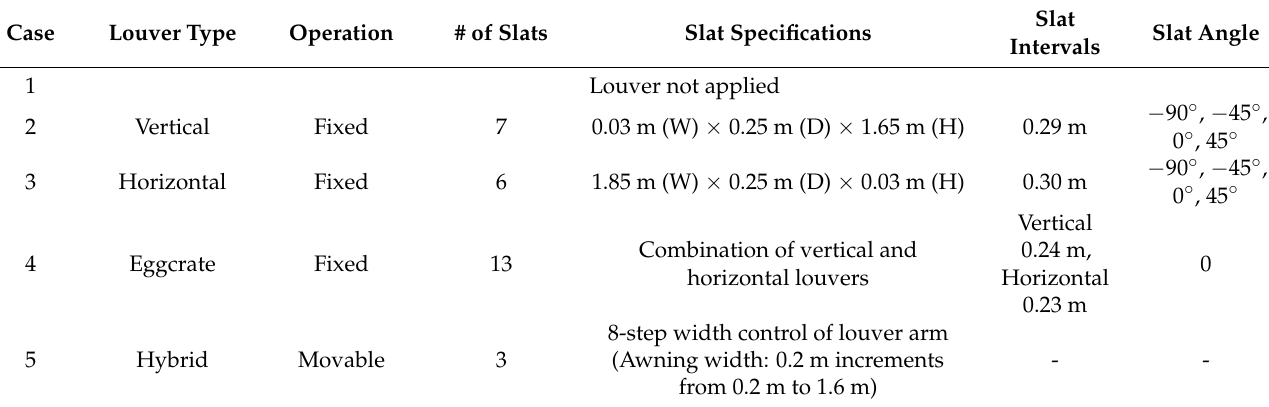
Table 3. Case settings for performance